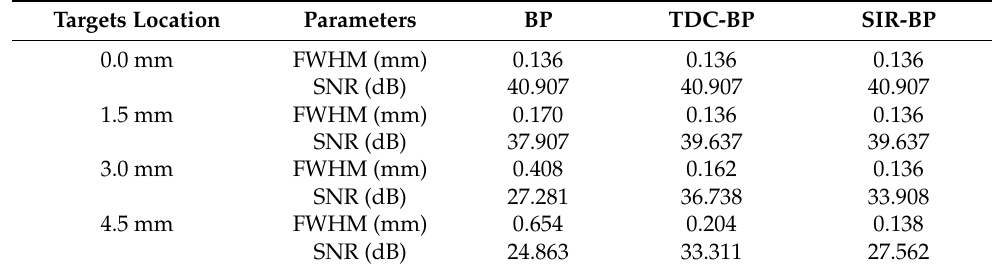
Table 1. The calculated FWHMs and SNRs of the four targets with different reconstruction methods. Targets